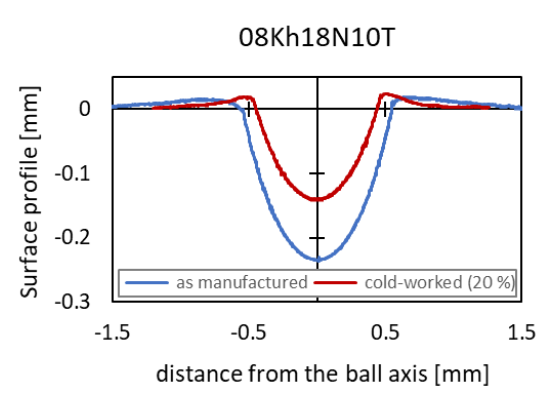
Figure 9. Cross-sectional profile of the spherical indent in undeformed a cold deformed 08Kh18N10T